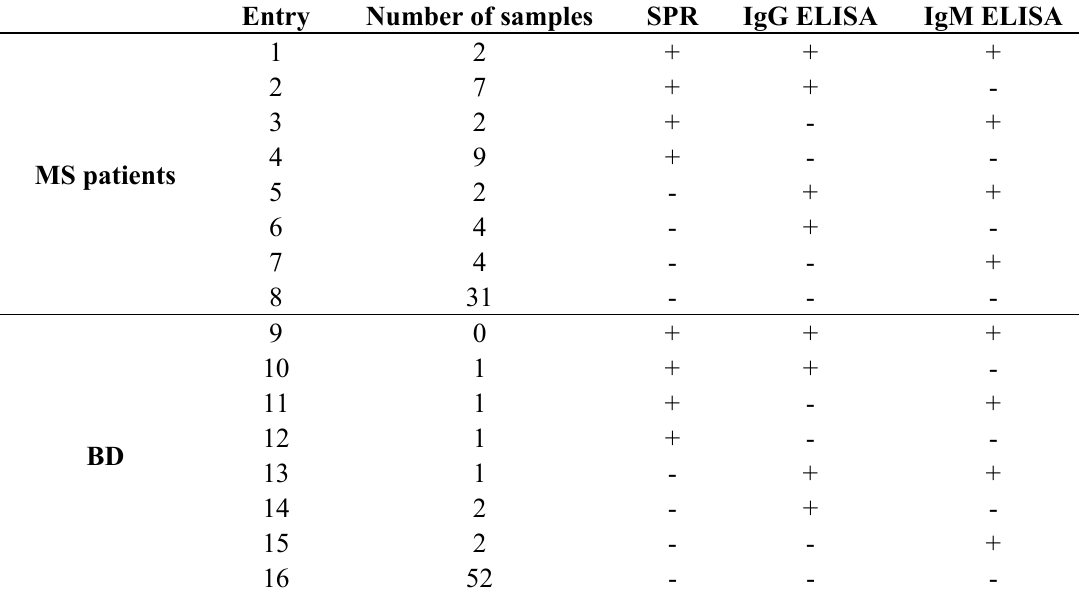
Table 1. Summary of all serological results obtained both in SPR and